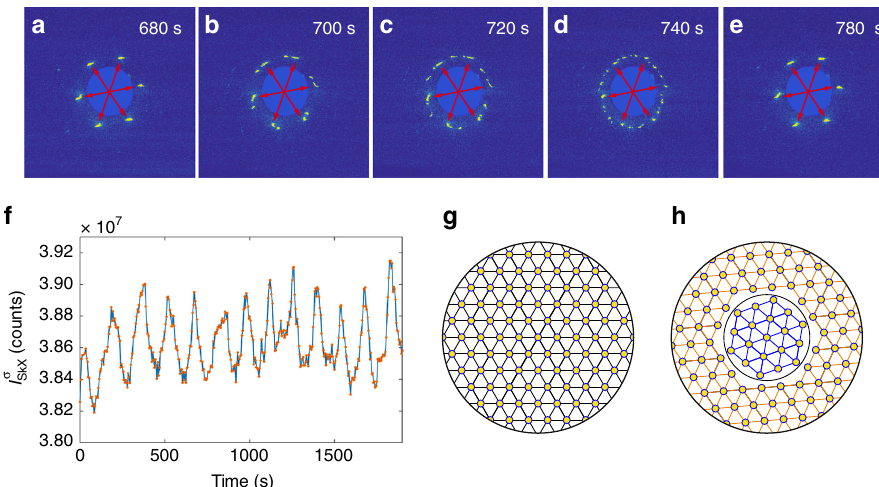
Fig. 5 Field gradient-induced skyrmion lattice dynamics due to dissipation and temperature fl uctuations. a – e Snapshots taken at different times during the rotation. The brightest skyrmion lattice peak set (marked by the red arrows) is locked after a certain period. The rest of the smaller domains keeps rotating for a fi nite lifetime, and the spots re-emerge shortly after having disappeared. f Total skyrmion lattice domain diffraction intensity as a function of time during the rotation. g , h Conceptual illustration of the rotation of skyrmion domains in circular racetracks. The annealed skyrmion lattice in g corresponds to the intensity maxima in f , and the minima to misaligned tracks illustrated in